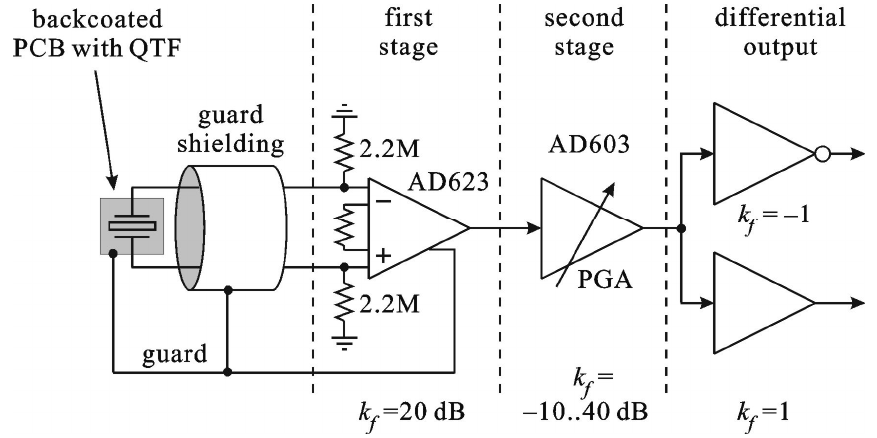
Figure 13. Block diagram of the proposed preamplifier.